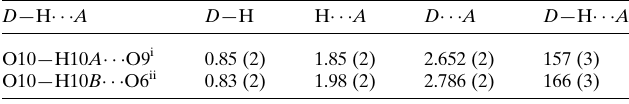
Table 1 Hydrogen-bond geometry (A˚ , (cid:5) ) for I .